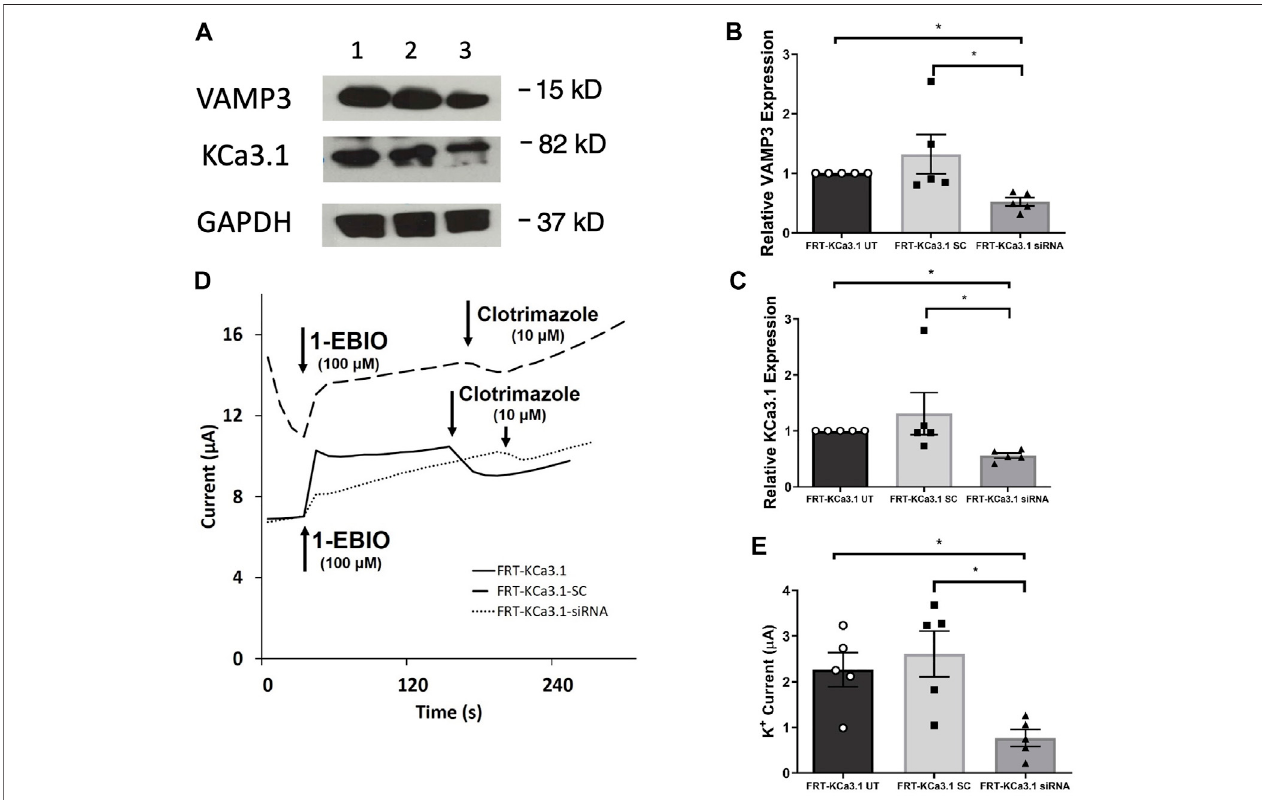
FIGURE2| ThemembraneexpressionandfunctionofKCa3.1inresponsetothesiRNAknockdownofVAMP3.FRT-KCa3.1-BLAPcellswerereversetransfected (20 pM, 48 h) with a scrambled siRNA (FRT-KCa3.1-SC) or siRNA to knock down VAMP3 (FRT-KCa3.1-siRNA). (A) Proteins from control FRT-KCa3.1 UT (untransfected withany siRNA, UT),FRT-KCa3.1-SC, and FRT-KCa3.1-siRNAcells wererun byimmunoblot(8% gel). Lanes wereloaded with 30 μ gofprotein. VAMP3 and KCa3.1 were detected in FRT-KCa3.1 cells. Lane 1: FRT-KCa3.1 UT, Lane 2: FRT-KCa3.1-SC, and Lane 3: FRT-KCa3.1-siRNA. GAPDH was used as